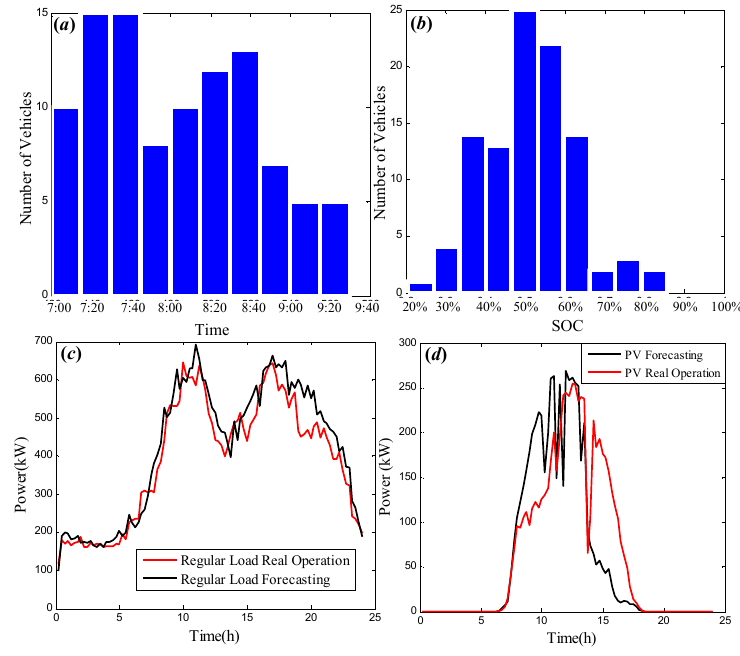
Figure 6. ( a ) EVs’ arriving time distribution; ( b ) EVs’ arriving SOC distribution; ( c ) real and forecasting data of the regular load; ( d ) real and forecasting data of PV.